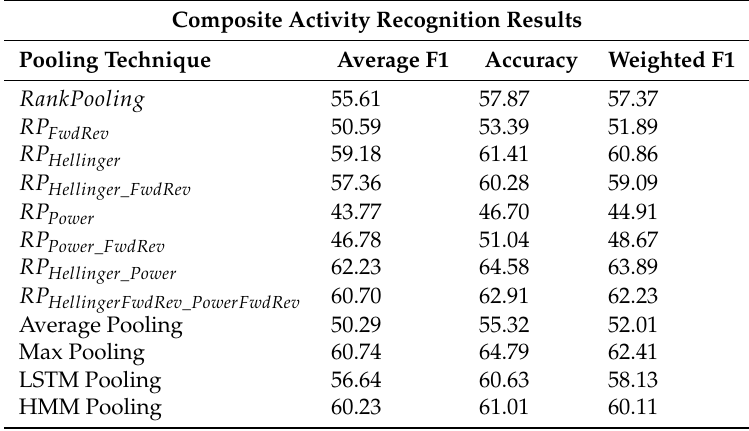
Table 4. Comparison of pooling techniques: leave-one-subject-out cross